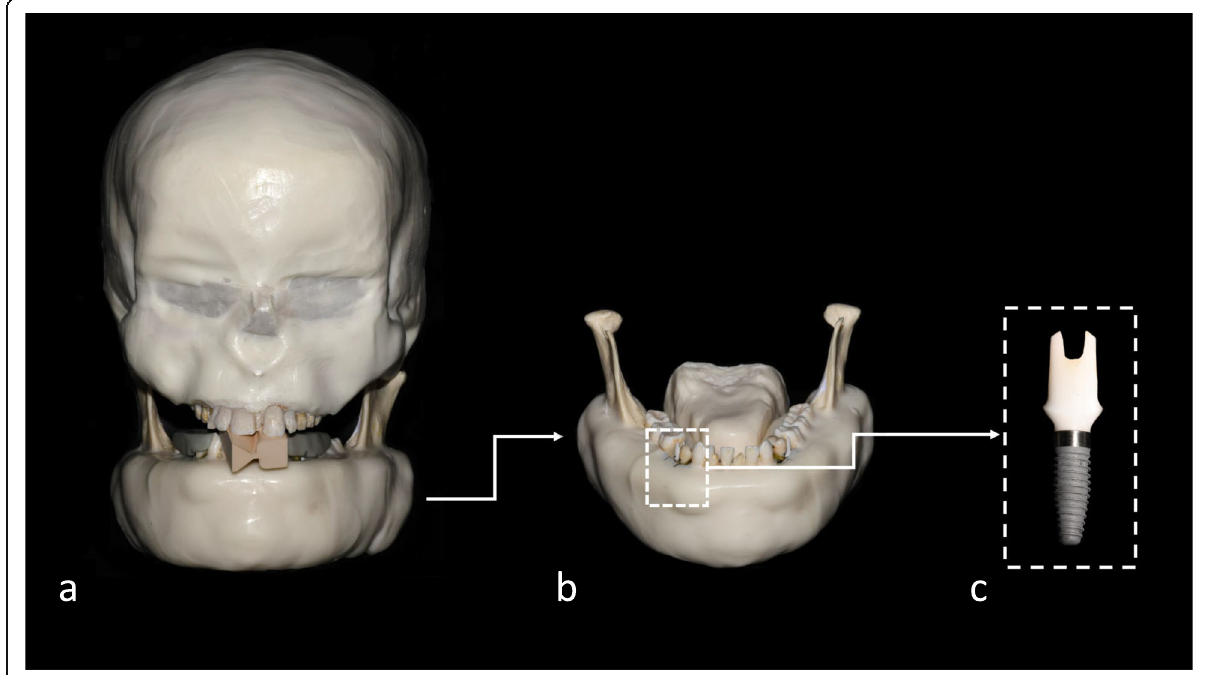
Fig. 1 Photographs of the imaging phantom. a Frontal view. b Frontal view of the mandible showing the tongue and implant of interest in place. c Magnified view of the studied